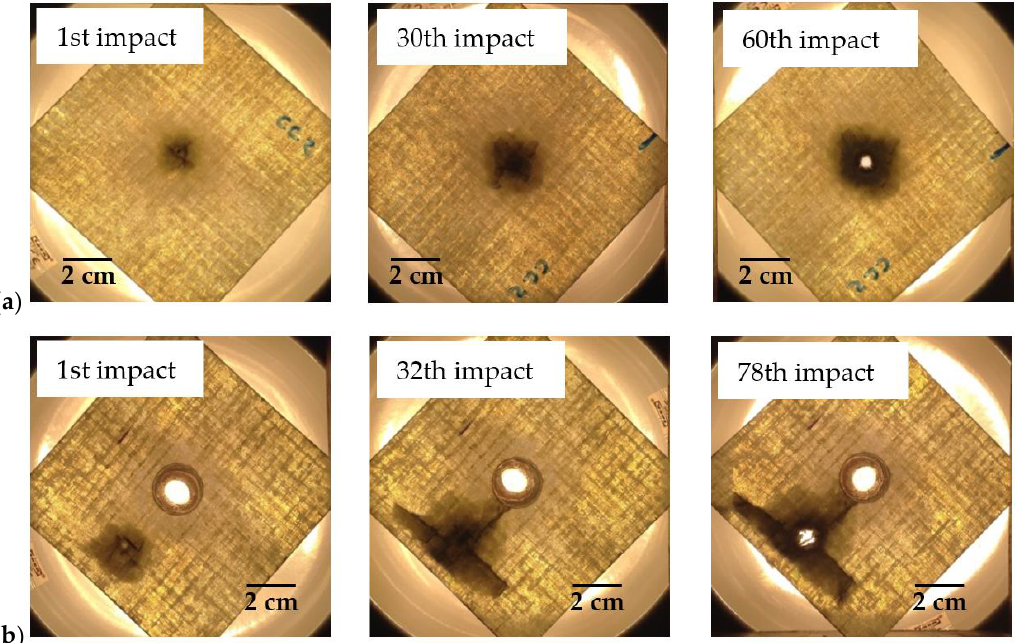
Figure 8. Damage evolution for control samples: ( a ) Without hole; ( b ) Impacted at 35 mm from the centre of the hole.